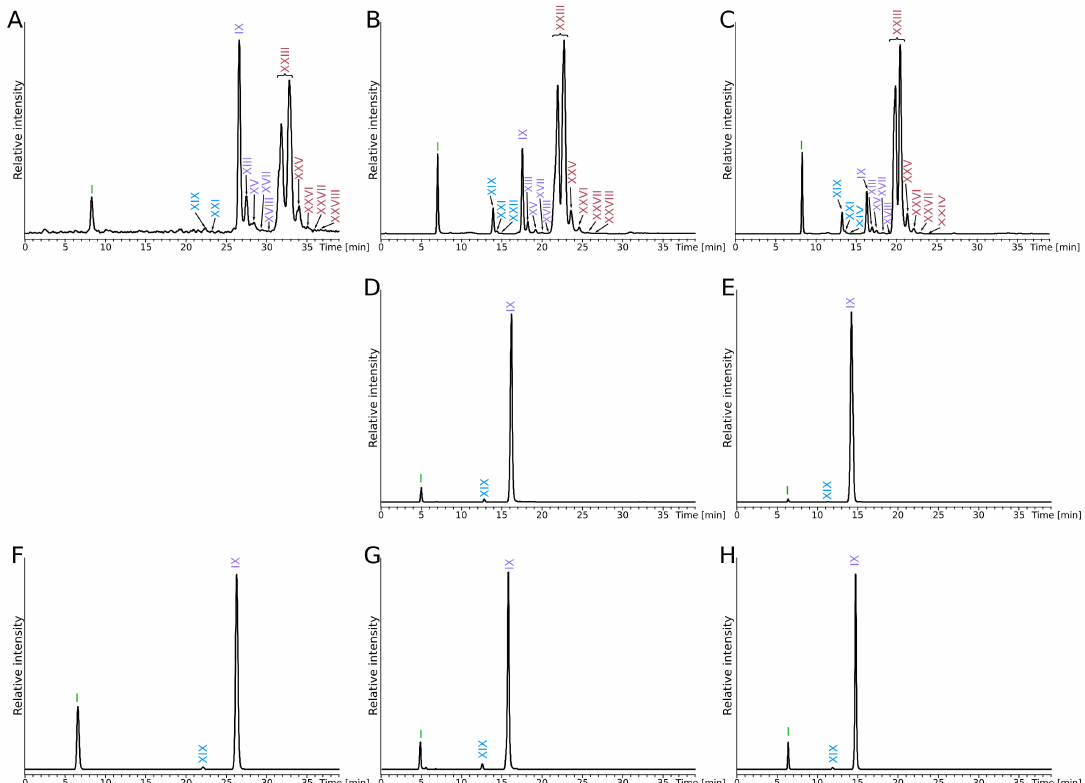
Figure 3. HPLC-APCI-MS chromatograms of core lipids from P. furiosus ( A – C ), P. yayanosii ( D , E ) and Thermococcus kodakarensis ( F – H ). Total CL ( A and F ) were recovered after direct methanolysis of the cell pellets. Note that the methanolysis of P. yayanosii biomass was not performed due to the low amounts of material available for this species. CL from the intact polar lipids ( B , D and G ) were obtained after methanolysis of the intact polar lipids (IPL) extracts. Residual CL ( C , E and H ) were recovered after methanolysis of the pre-extracted cells. Chromatograms were drawn by extracting the following protonated ions: 653, 1292, 1294, 1296, 1298, 1300, 1302 and 1304. Refer to Figure 1 for lipid structures and their corresponding